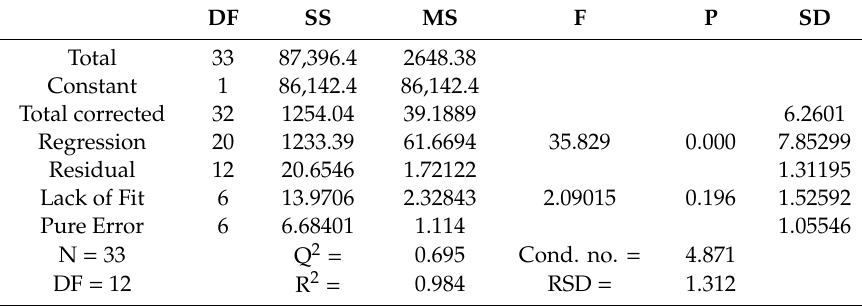
Table 4. Lack of Fit coe ffi cient of Flavourzyme-catalyzed hydrolysis. DF SS MS